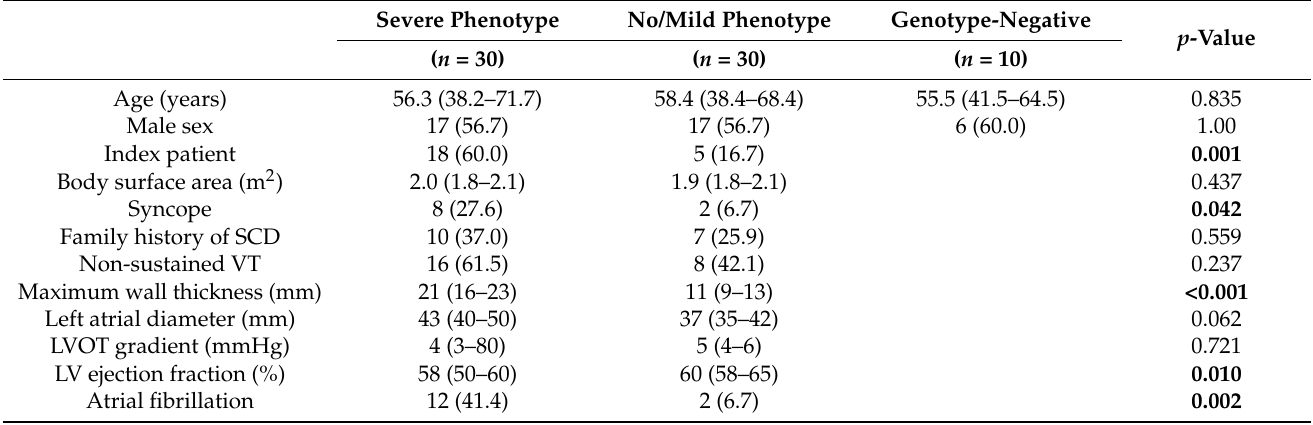
Table 1. Subject characteristics. Data shown as counts (%), means (standard deviation), or medians [interquartile range]. p -values are provided for comparisons across groups for age and sex and for comparisons between the severe and no/mild phenotype groups for the remaining variables; p -values < 0.05 are highlighted in bold. Family history of sudden cardiac death was defined in accordance with the HCM-Risk SCD calculator [14]. SCD, sudden cardiac death; VT, ventricular tachycardia; LVOT, left ventricular outflow tract; LV, left ventricular. Severe Phenotype No/Mild